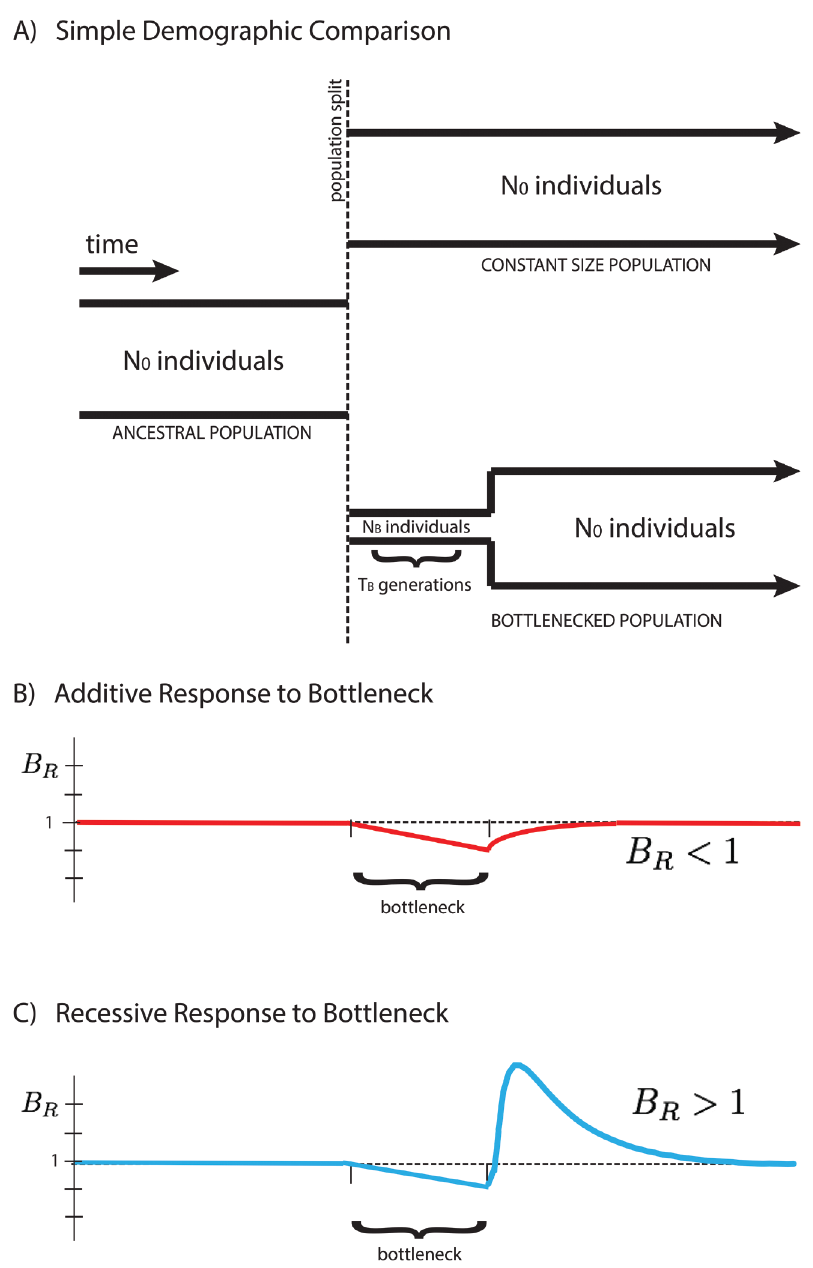
Fig 1. Response of the B R statistic for additive and recessive variation. A schematic representation of two populations is presented above ( A ). Initially a single population prior to the bottleneck event, the populations split and have distinct demographic profiles. The equilibrium population maintains a constant size for easy comparison to the founded population. The latter drastically reduces its population size to N B for a short time T B during the founder ’ s event. Our statistical comparison between populations B R ¼ h x i eq represented here for cases of purely additive ( B ) and purely recessive ( C ) variation. The statistic B R > 1 for recessive variation (dominance coef fi cient h = 0) and B R < 1 for additive variation ( h = 1/2), providing a simple indicator for the primary mode of selection of polymorphic alleles in the